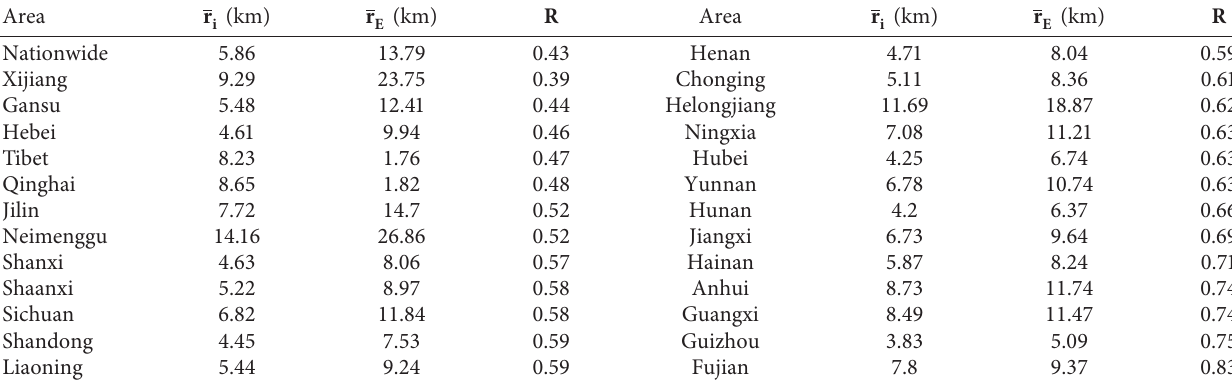
Table 1: The nearest neighbor index of pro-poor tourism